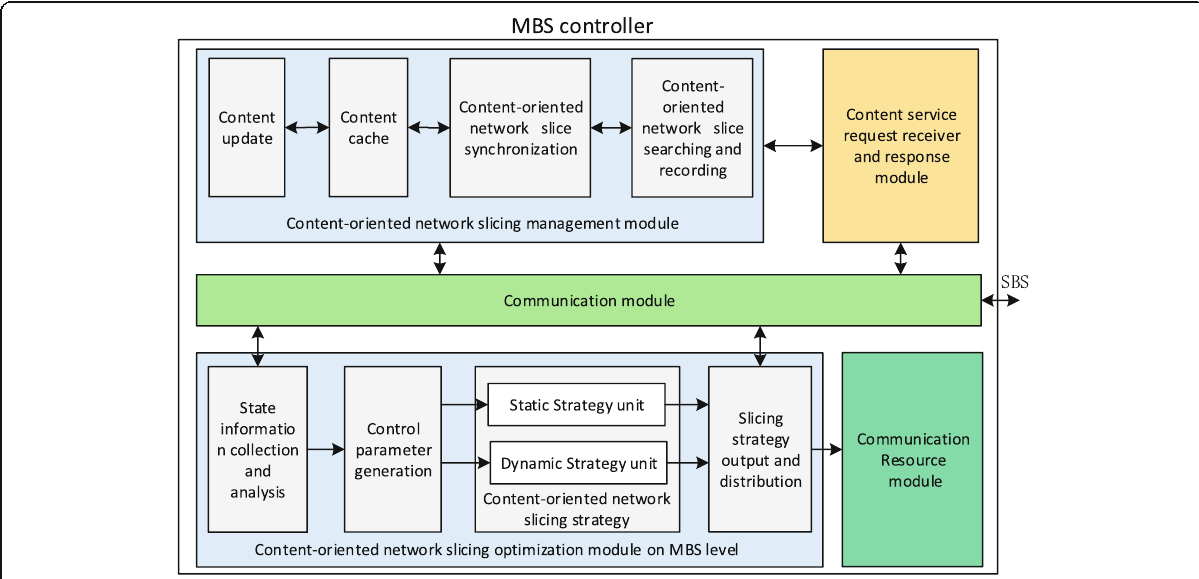
Fig. 4 The functional modules in a MBS controller